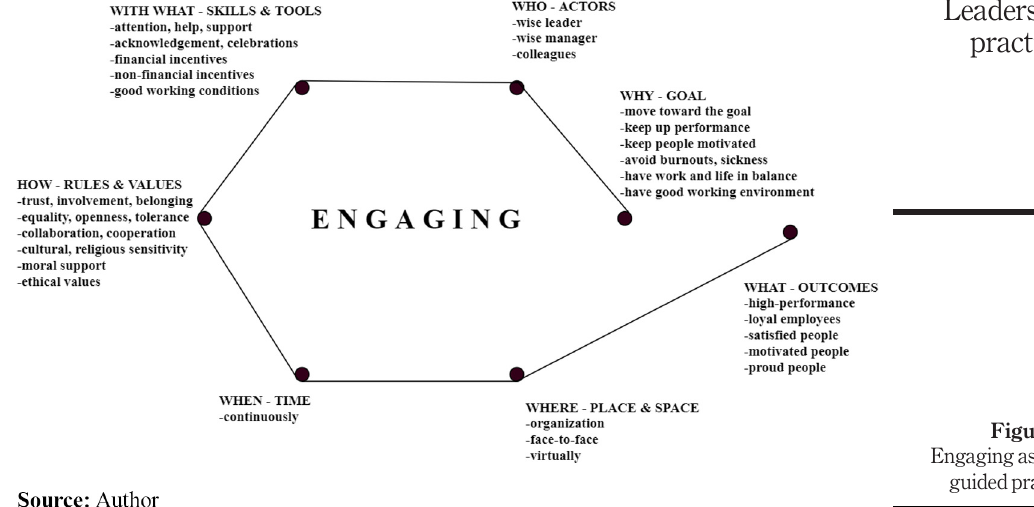
Figure 6. Engaging as PW-